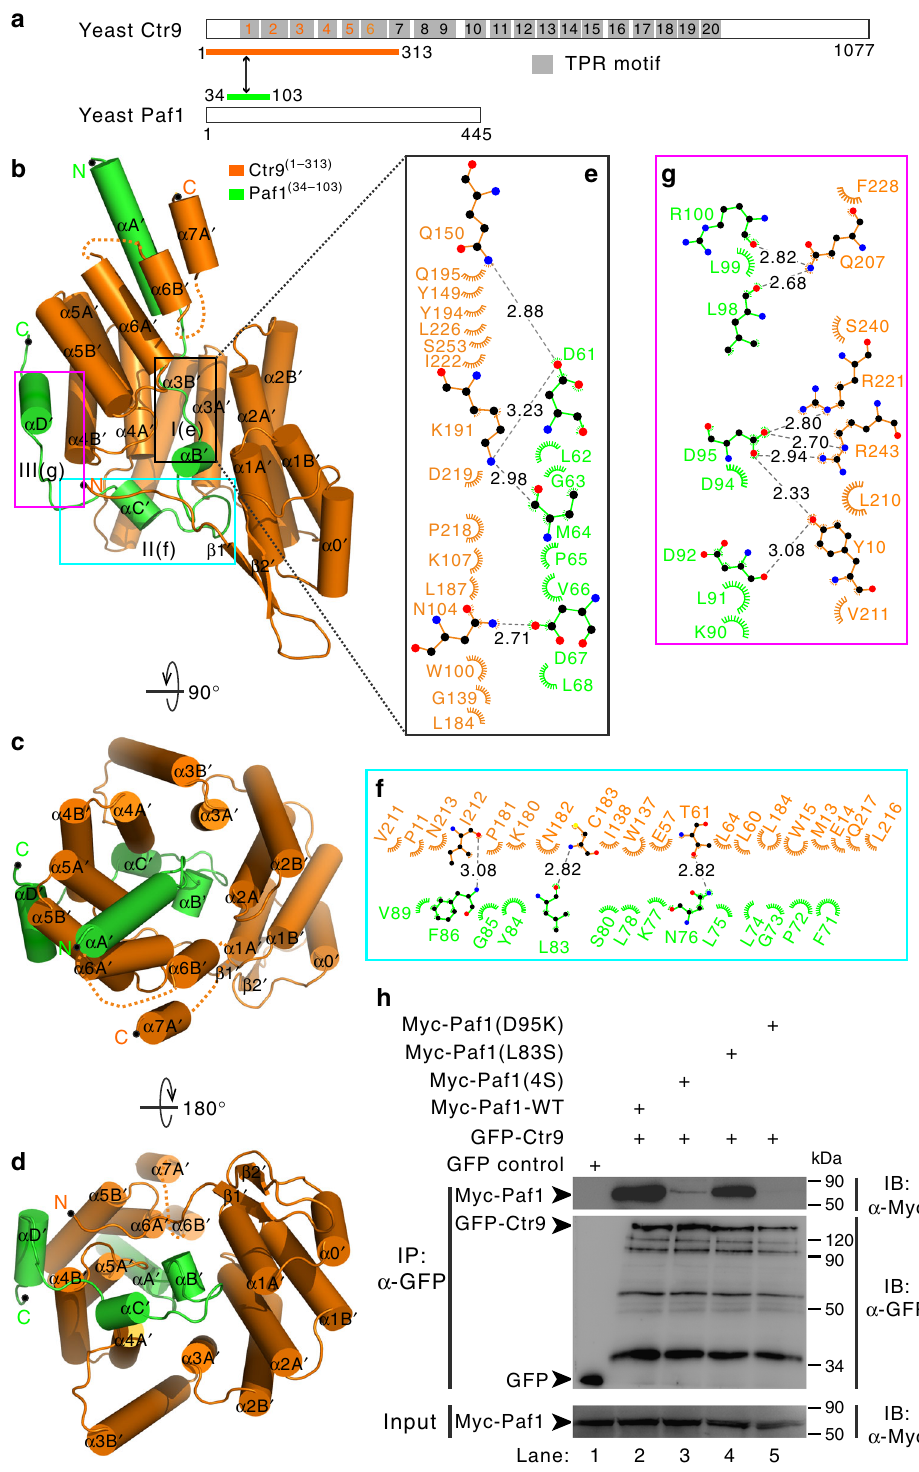
The deletion of the CTR9 gene locus with PAF1 locus ampli fi cation may synergistically lead to initiation and progression of pancreatic cancer 37 . A total of 38 and 17 missense mutations were located in 38 residues of CTR9 (1 – 249) and 12 residues of PAF1 (57 – 116)